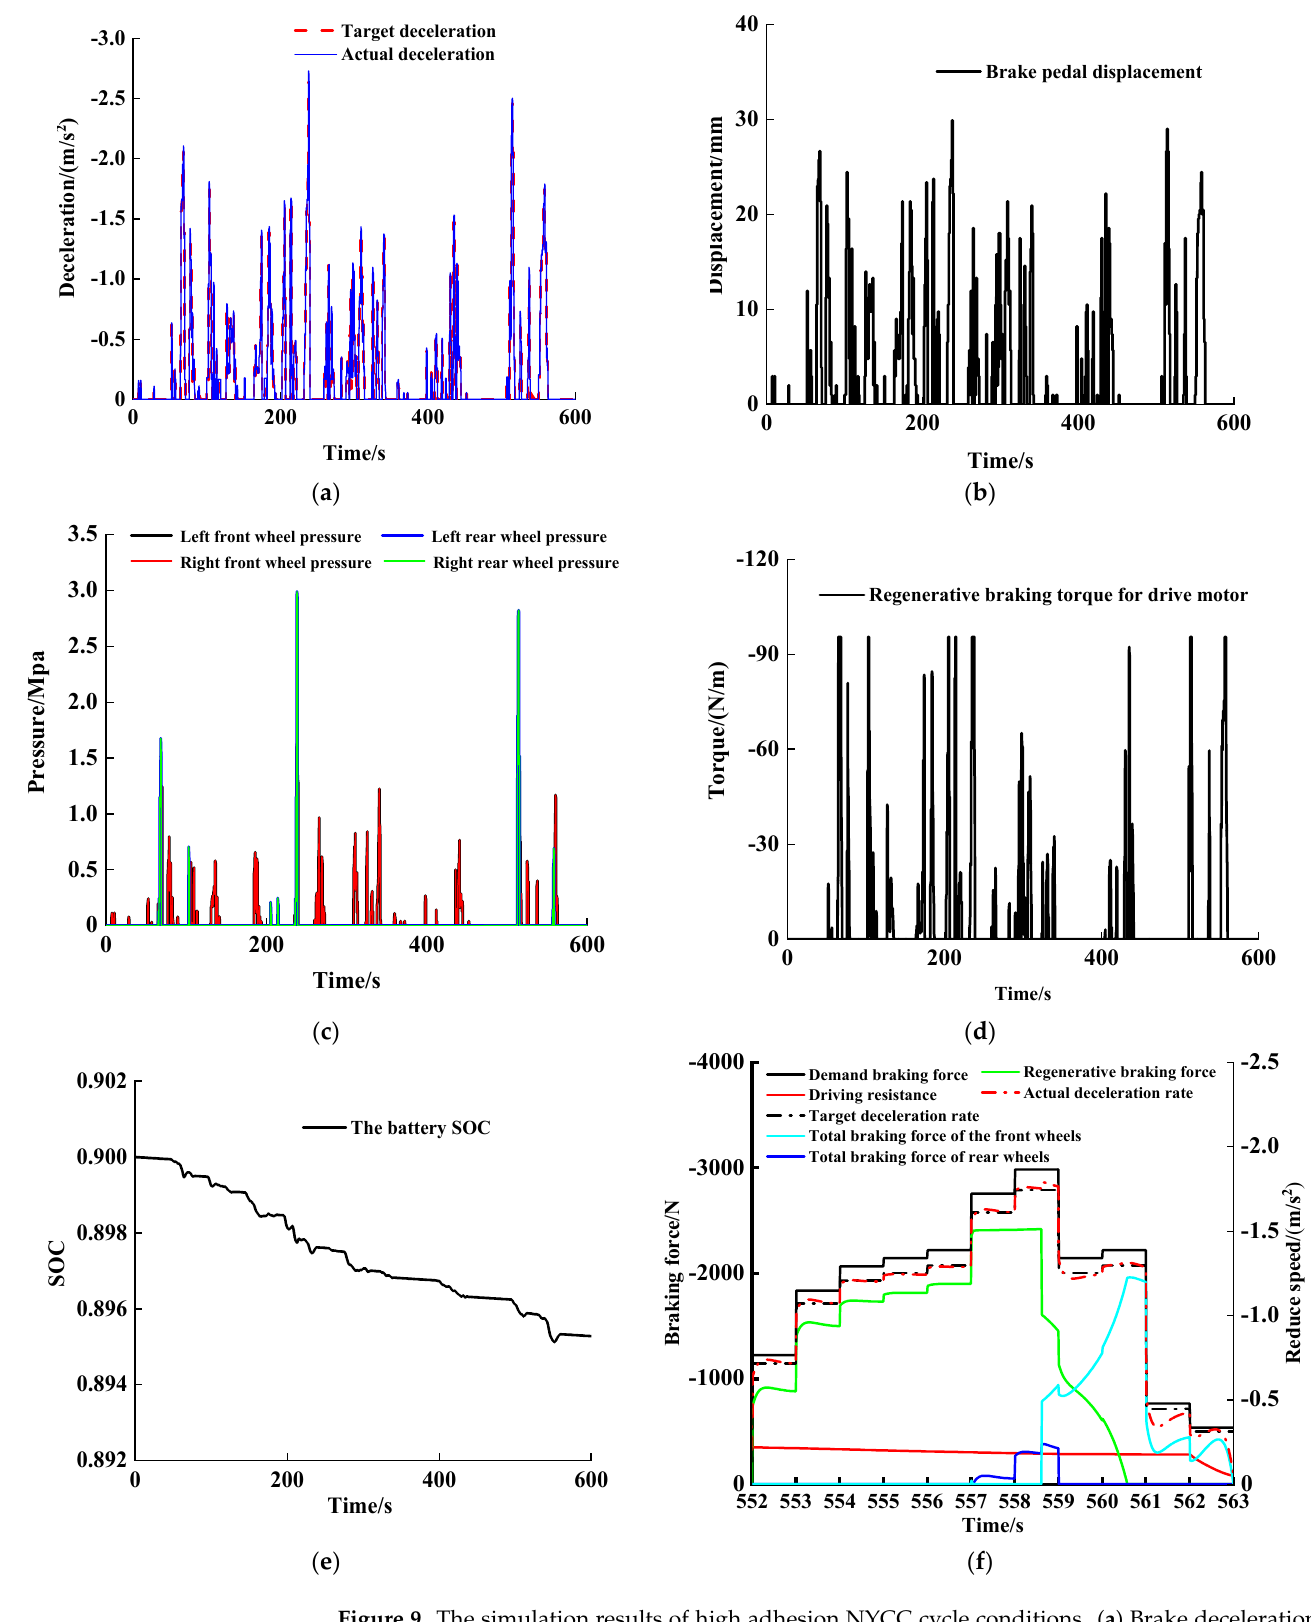
Figure 9. The simulation results of high adhesion NYCC cycle conditions. ( a ) Brake deceleration. ( b ) Brake pedal displacement. ( c ) Brake pressure. ( d ) Regenerative braking torque for drive motor. ( e ) The battery SOC. ( f ) Braking force distribution in 552~563 s.